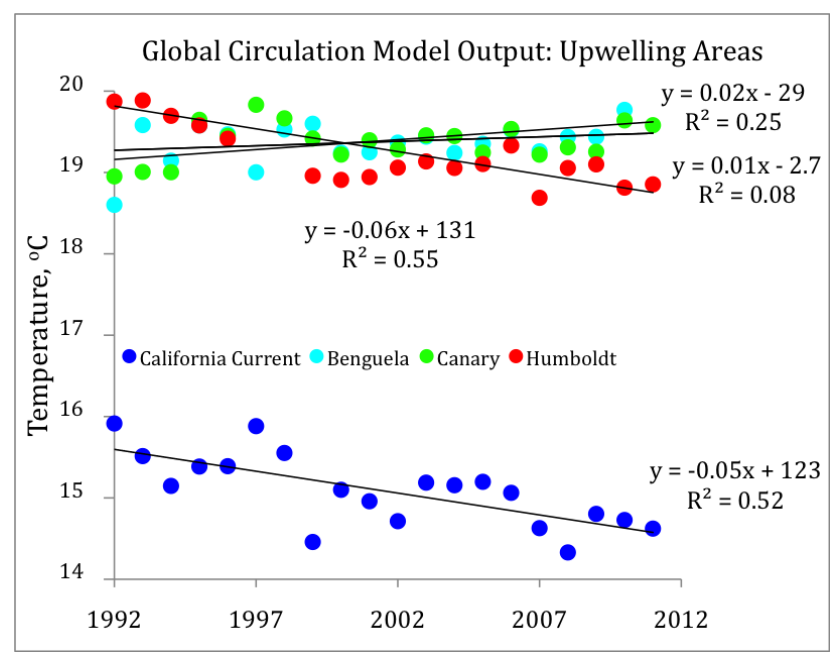
Figure 5. The Massachusetts Institute of Technology (MIT) global circulation model temperature for upwelling zones in Figure 4a. Slopes of linear regression lines indicate coherence with Figure 4b and are positive for Canary and Benguela and negative for California and Humboldt currents for available model output period 1992 to 2012. The state estimates were provided by Estimating the Circulation and Climate of the Ocean, Phase II (ECCO2) Consortium for Estimating the Circulation and Climate of the Ocean funded by the National Oceanographic Partnership program (NOPP).